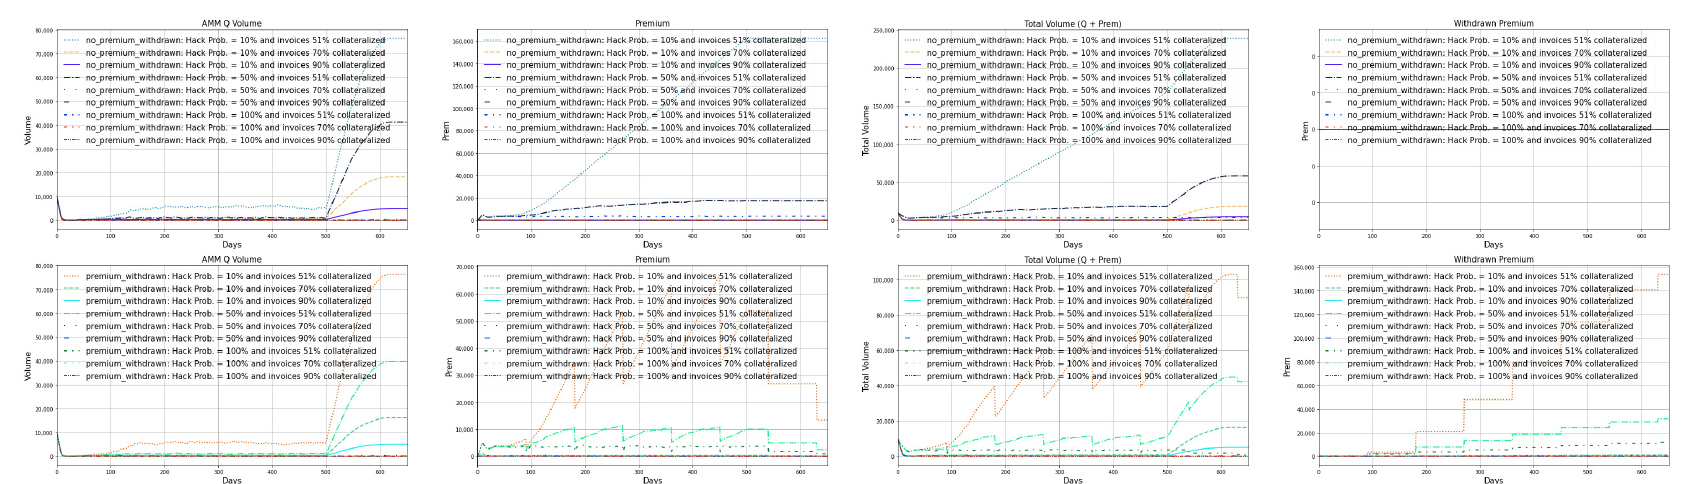
Figure A15. rkAMM Curves from simulation of hack scenario and 1 day of withdrawal period.